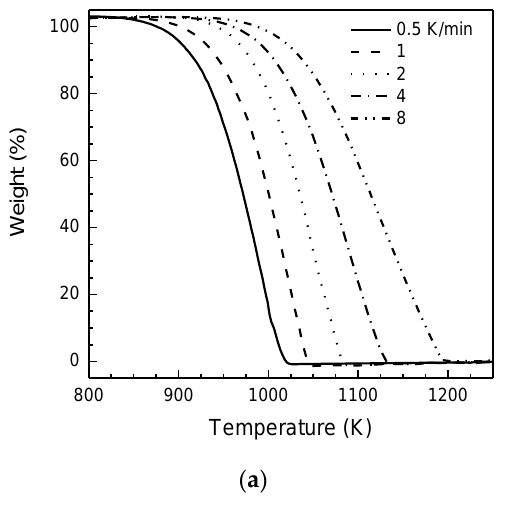
Figure 2. ( a ) Dynamic mass loss of nuclear-grade graphite powder at various heating rates under dry air. ( b ) Isoconversional plot for calculating the activation energy of nuclear-grade graphite gasification under dry air. gasification under dry air.